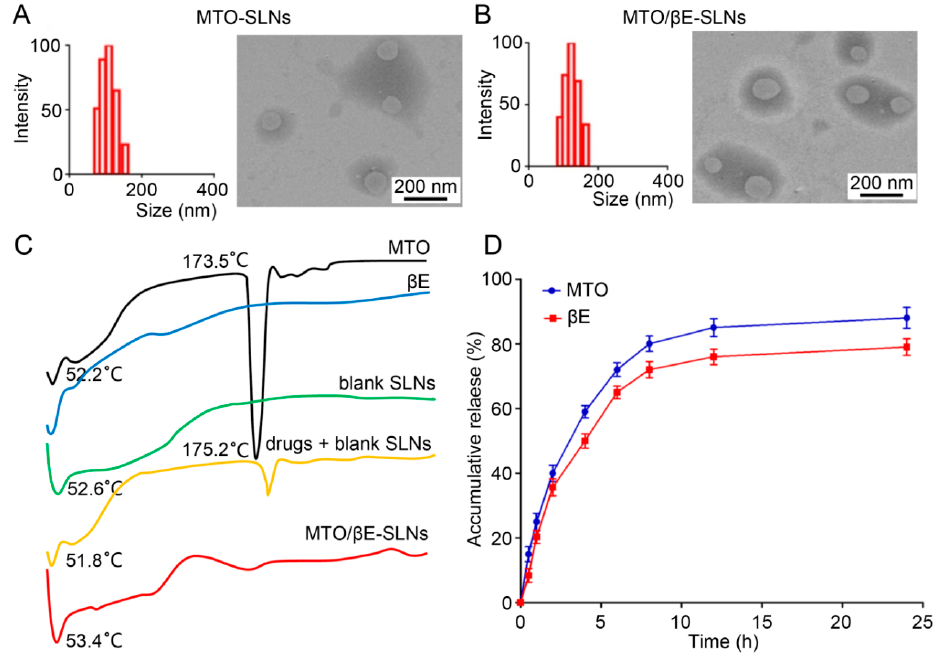
Figure 1. ( A , B ) The particle size and TEM images of ( A ) MTO-SLNs and ( B ) MTO / β E-SLNs. ( C ) The differential scanning calorimetry (DSC) analysis of MTO powder, β E, blank SLN powder, physical mixture of drugs (MTO / β E) and blank SLNs powder, MTO / β E-SLNs powder. ( D ) The in vitro release